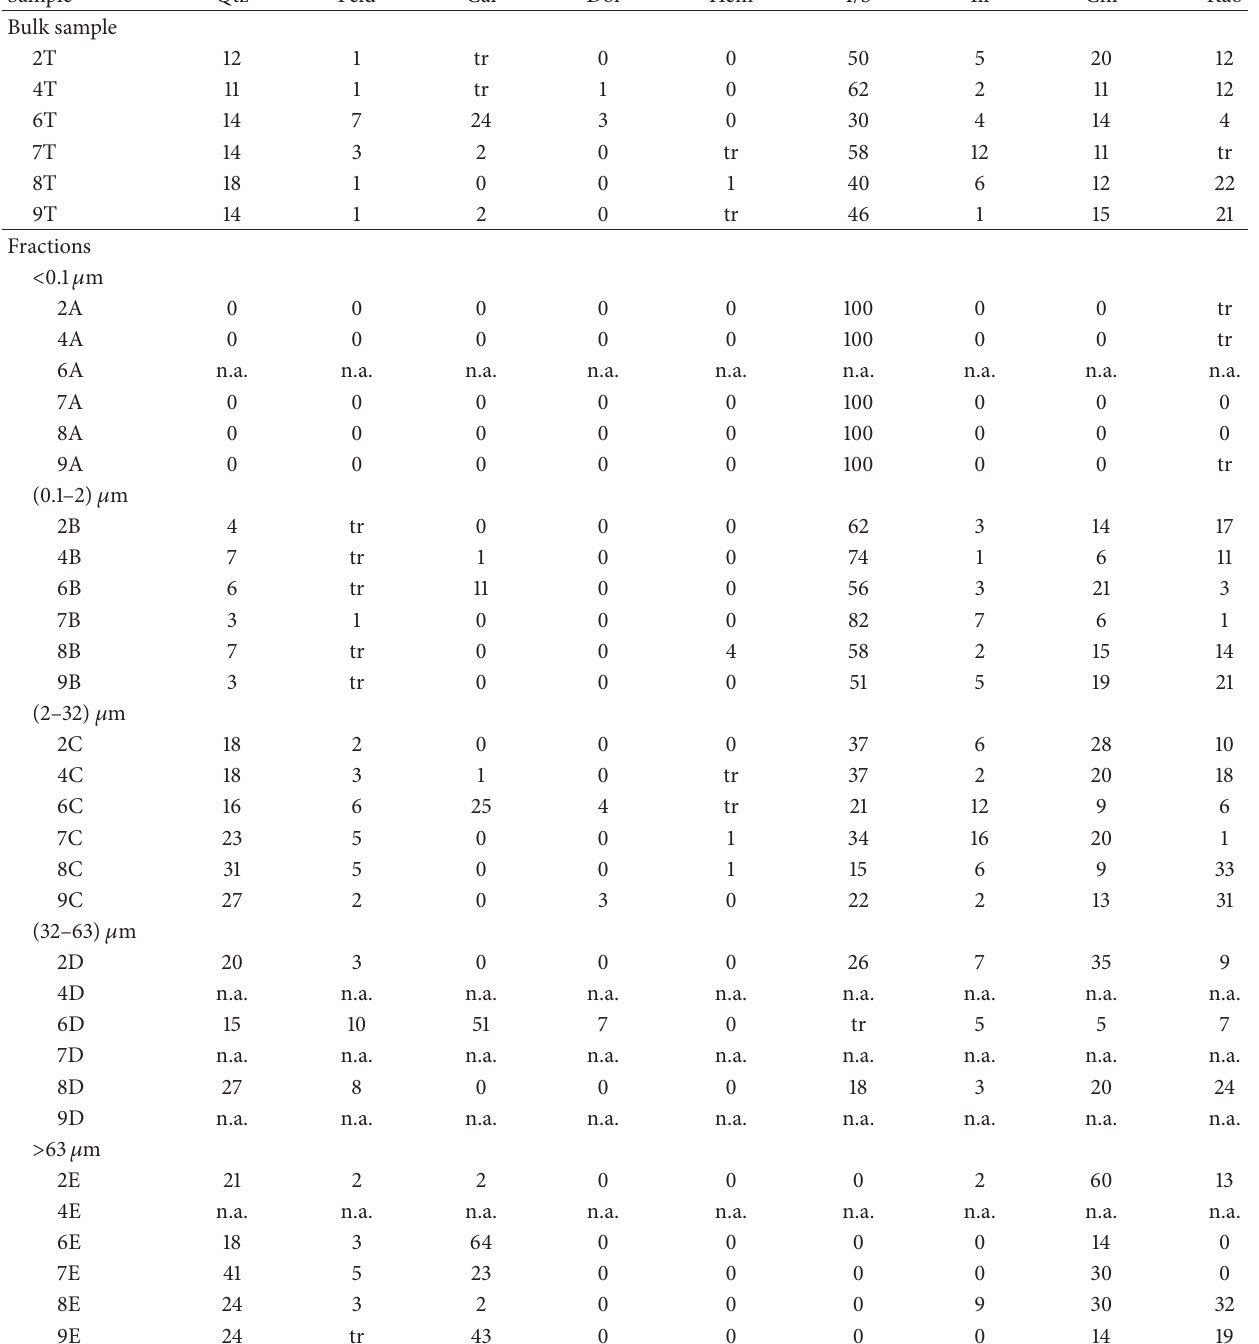
Table 1: Mineralogical composition of the bulk sample and different